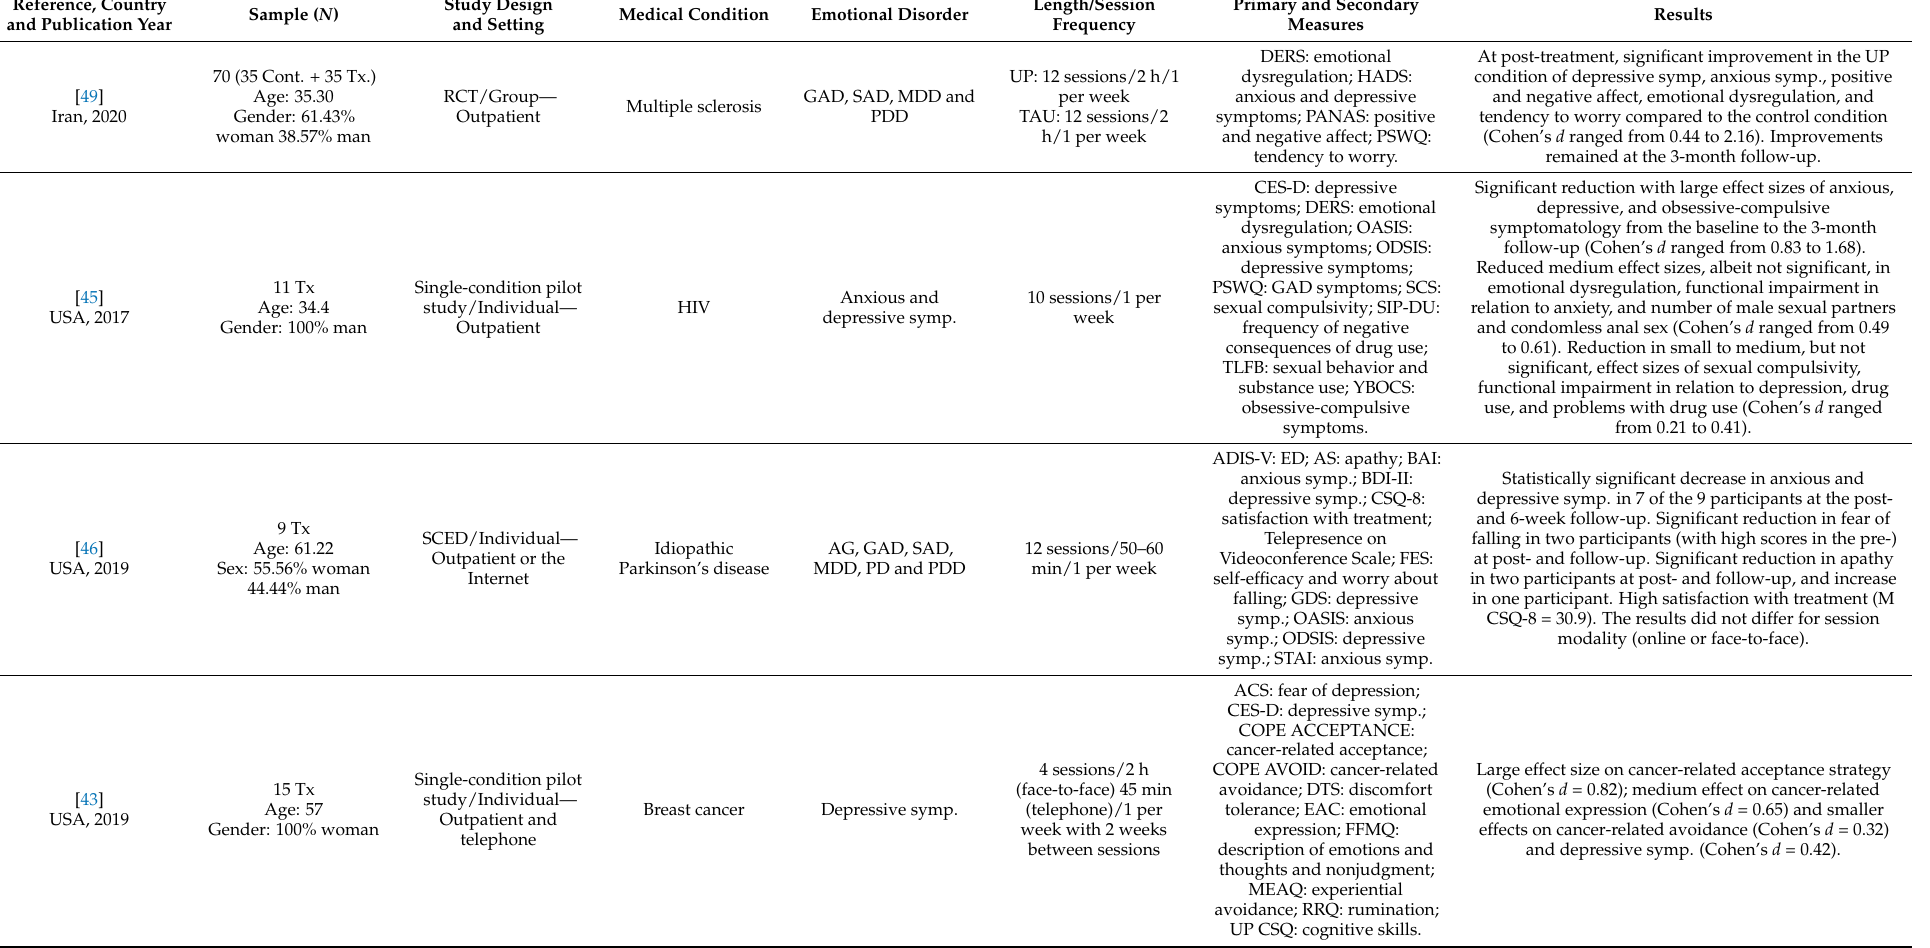
Table 2. Characteristics of the included research